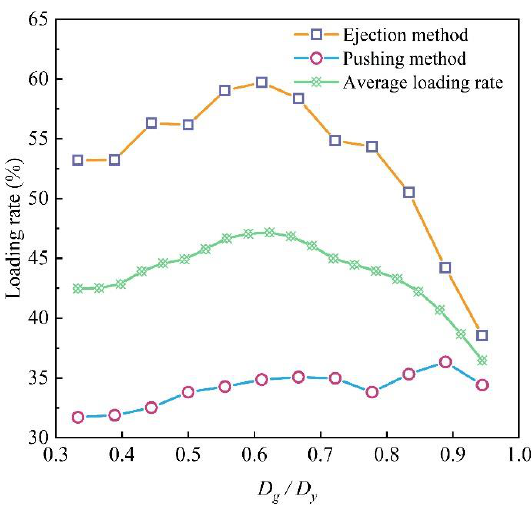
Figure 20. Comparison of loading rate under ejection and pushing conditions ( D y = 900 mm). modes is their different conveying mechanisms. With the ejection loading mode, both the input half and the conveying half of the loading drum are close to the coal wall. The par- ticles that are cut off by the pick are directly affected by the spiral blades and allow the axial speed to flow in the direction of the scraper. As the conveying half is close to the coal wall, it is beneficial for the particles to stay in the enveloping zone during the conveying process. Meanwhile, particles at the end of the drum are subjected to the tangential ejec- tion velocity of the blades to obtain a vertical upward velocity component, which is con- ducive to completing the loading across the gap area. Using the pushing mode, the con- veying half and the input half are the two halves of the drum. The particles are intercepted in the enveloping zone of the blades and move in a circular motion into the conveying half under the tangential action of the blades. Since the rear side of the conveying half is the goaf area, the probability of particles being thrown into the goaf during conveyance increases, causing the conveying efficiency of the drum to decrease. 3.3.2. Comparison of Particles’ Axi al Velocities under Ejection and Pushing Conditions The comparison of particles’ axial velocities with different loading modes is shown in Figure 21. The variation laws of particles’ axial velocities with the barrel diameter are consistent with the two loading modes. With the increase in barrel diameter, the particles’ axial velocities first increase and then decrease. In addition, the particles’ axial velocities with ejection are significantly higher than they are with pushing, especially when the bar- rel diameter is small. With pushing, the contact force between the particles clearly